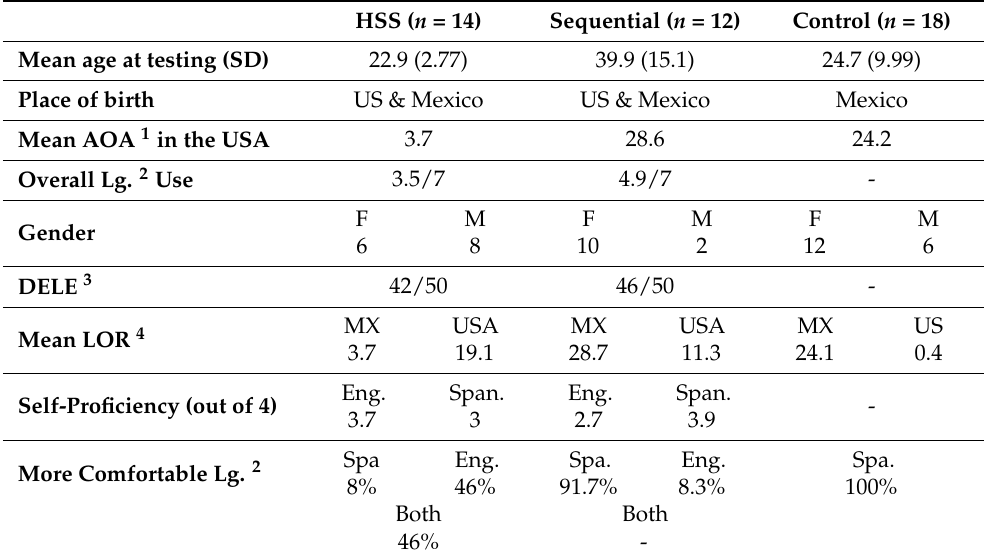
Table 1. Participants’ demographic